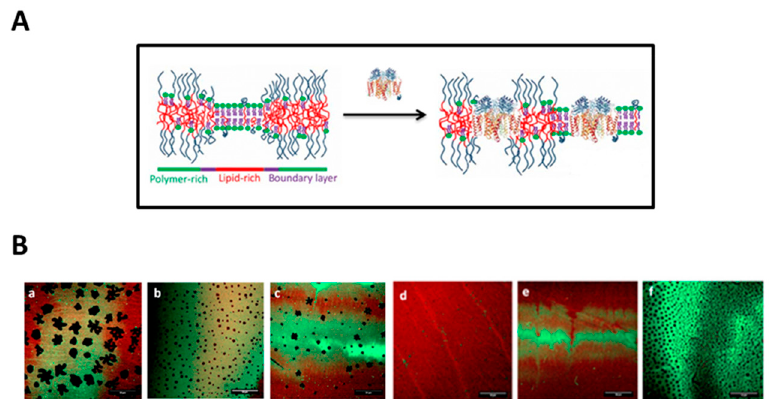
Figure 14. ( A ) Schematic representation of selective reconstitution of an outer membrane protein into the lipid rich domain of a polymer-lipid hybrid membrane; [371]. ( B ) CLSM micrographs showing the protein distribution in films consisting of mixtures of PDMS 65 - b -PMOXA 12 and (a) DPPC (x DPPC = 0.75), (b) DPPC (x DPPC = 0.5), (c) DPPE (x DPPE = 0.25), (d) DOPC (x DPPC = 0.25), and (e) POPE (x DPPC = 0.25). (f) PDMS 37 -b-PMOXA 9 mixed with DPPE (x DPPE = 0.5). Films are transferred at a surface pressure of 35 mN·m –1 . Scale bars correspond to 50 µm [6]. Reproduced from Beales et al. (2017) (Copyright ©